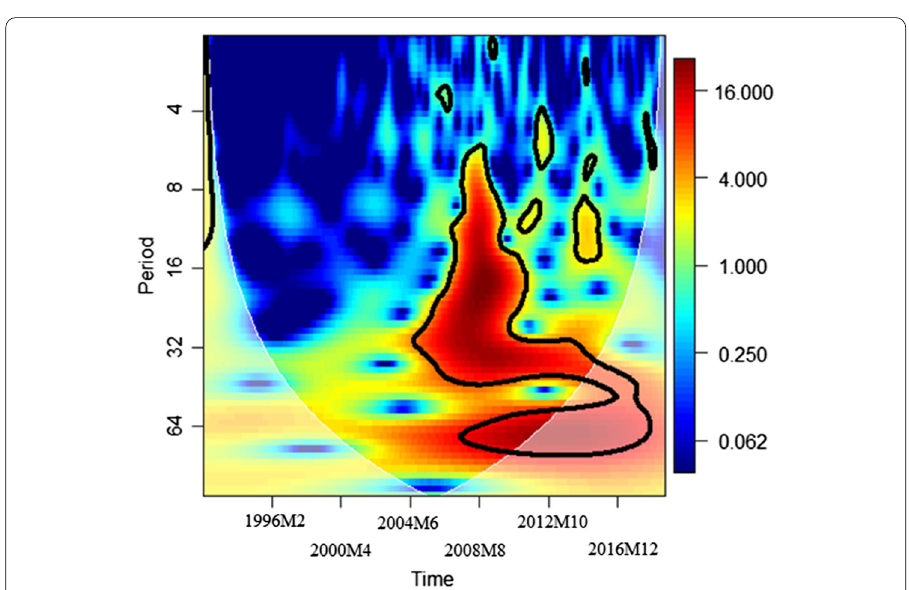
Fig. 2 Wavelet power spectrum for energy price